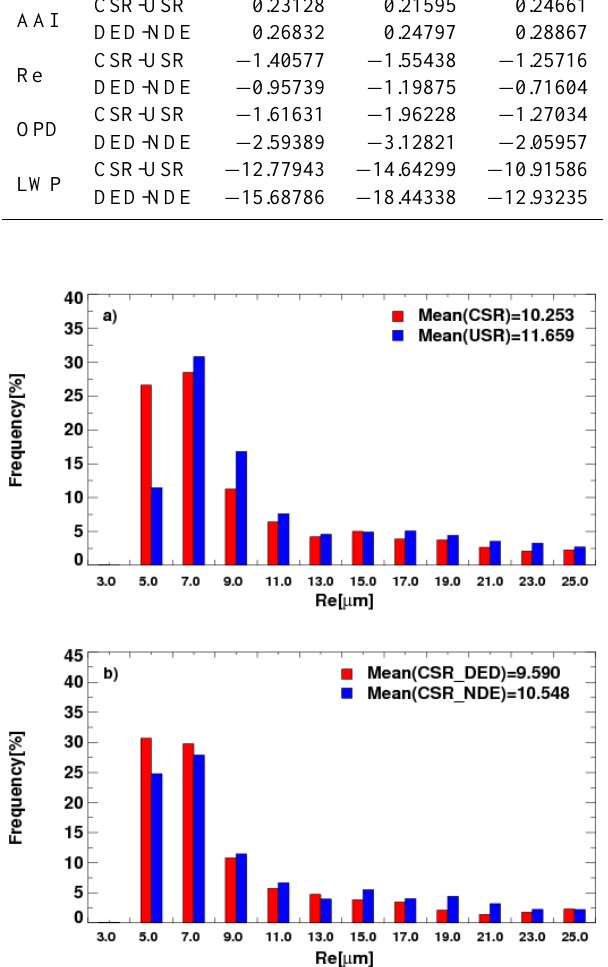
Fig. 7. Same as Fig. 5, except for water cloud radius ( Re ). The histogram intervals are 2 μ m.